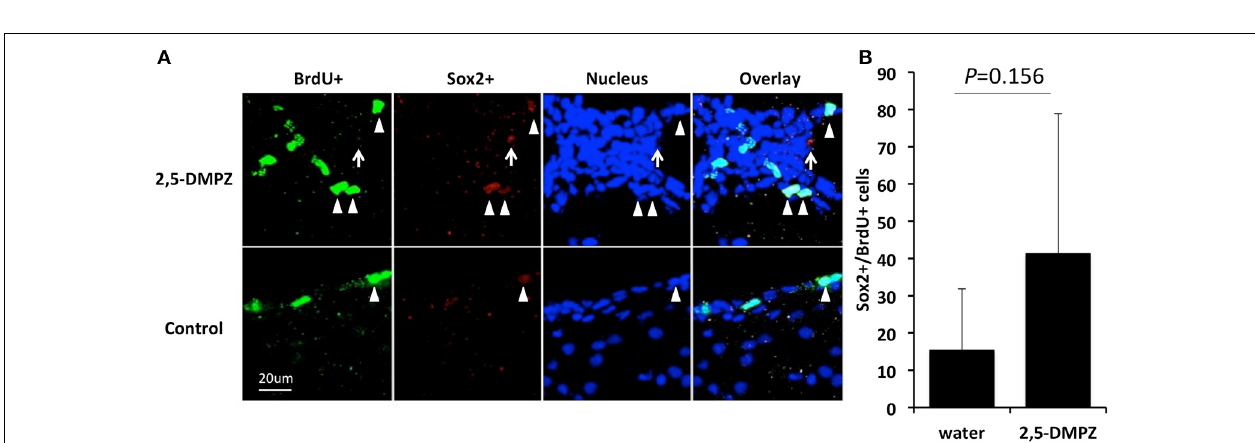
compared to males exposed to water ( n = 7) (Dunnett test, P < 0 . 001). Male mice exposed to female-soiled bedding ( n = 8) and male-soiled bedding ( n = 7) showed higher cell proliferation in the SVZ compared to males exposed to clean bedding ( n = 6). ∗∗∗ : P < 0 . 001, ∗ : P < 0 . 05. Chemical structure of 2,5-dimethylpyrazine is shown in the figure. Other pair-wise comparisons with control group were not significant.